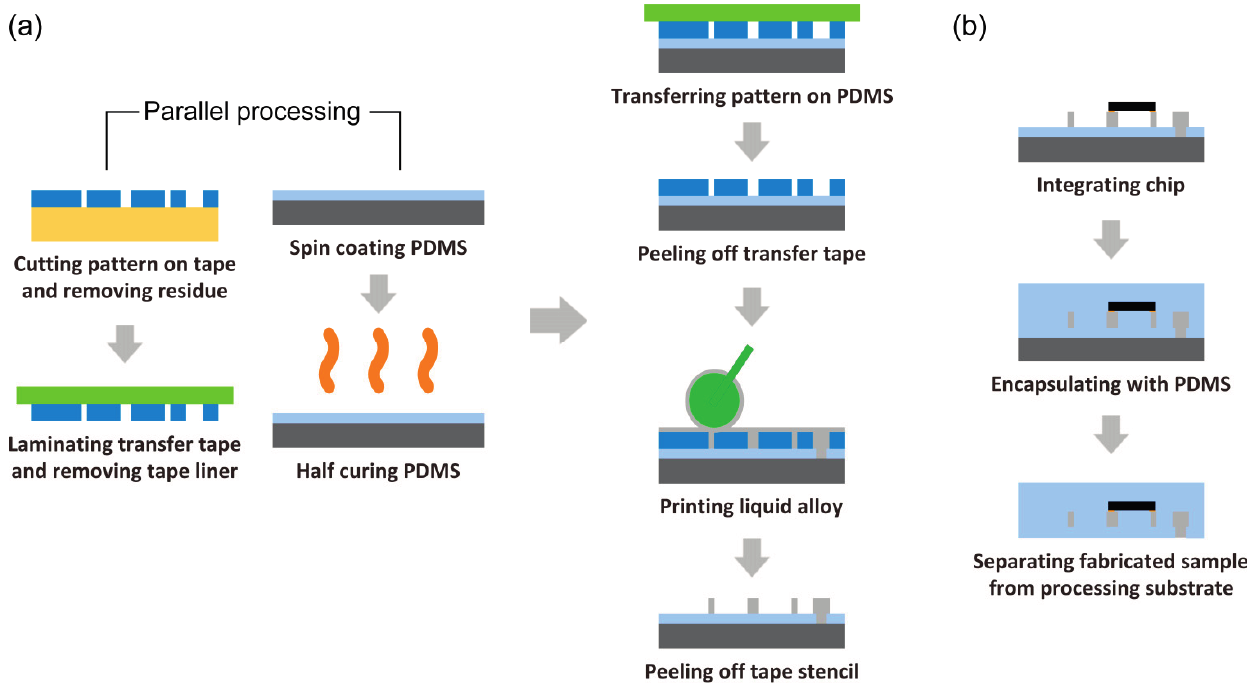
Figure 1. Processing steps of ( a ) tape transfer printing and ( b ) device